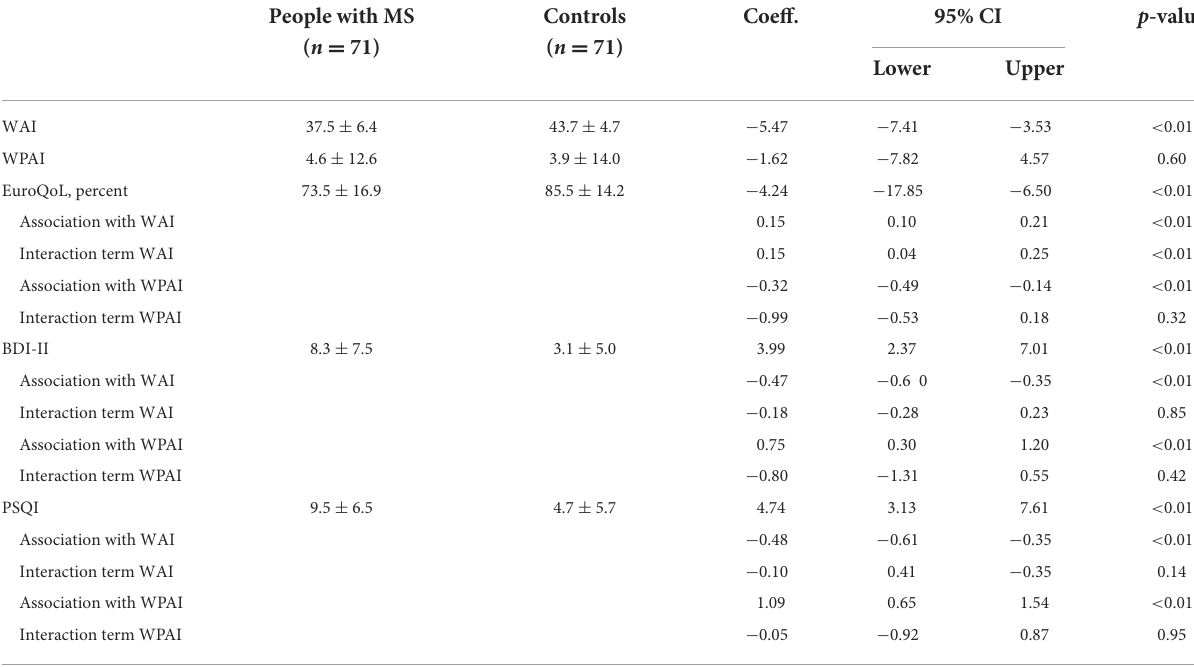
TABLE 2 Working impairment in people with MS and controls, and their associations with clinical features. People with MS Controls Coeff. 95% CI p -value ( n = 71) ( n = 71) Lower